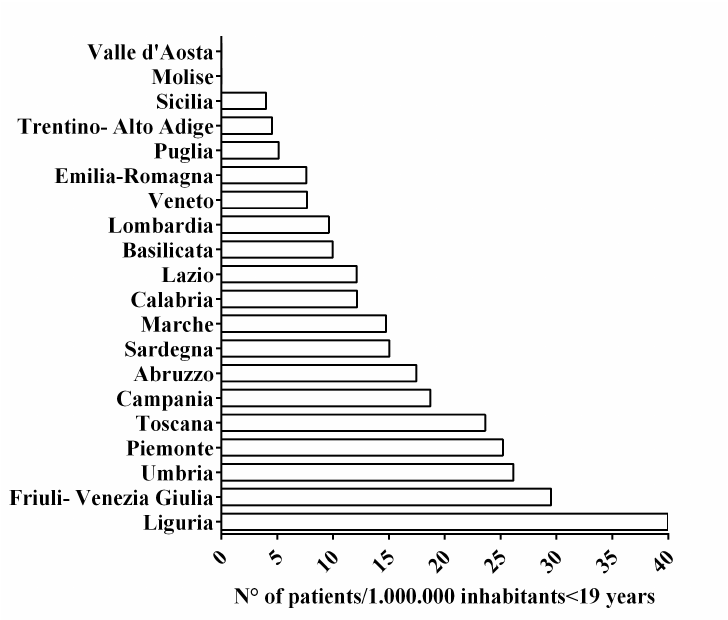
Figure 1. Regional prevalence.